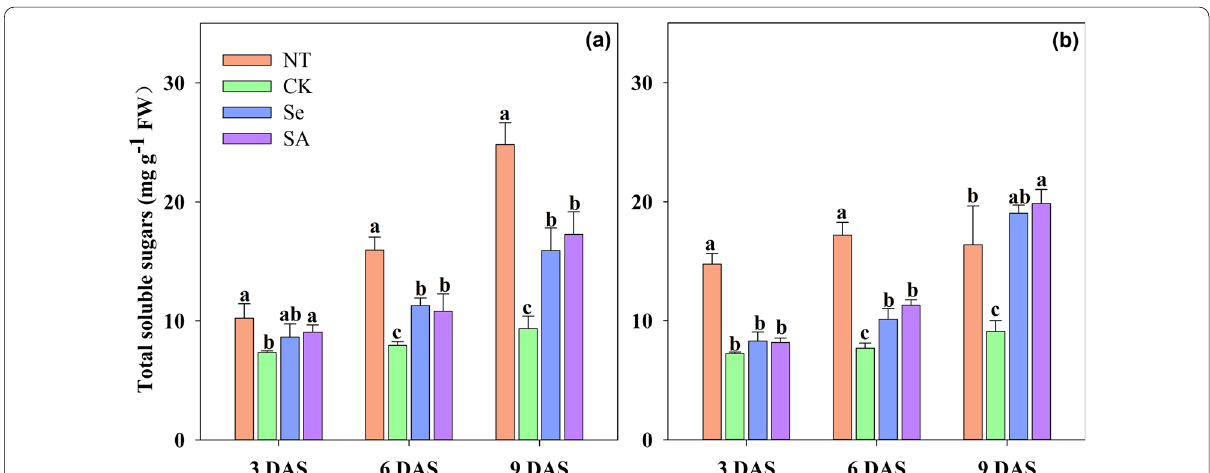
Fig. 3 Changes in total soluble sugar contents of primed and non-primed rice seeds under control temperature and chilling stress. a EZ18. b LY287. DAS, days after sowing; EZ18, ezao18; LY287, liangyou287; NT, no priming-normal temperature control; CK, no priming-chilling stress; Se, Selenium priming-chilling stress; SA, Salicylic priming-chilling stress. Error bars indicate standard error (n differences at the 5% level according to LSD test among four treatments within the same DAS of the same